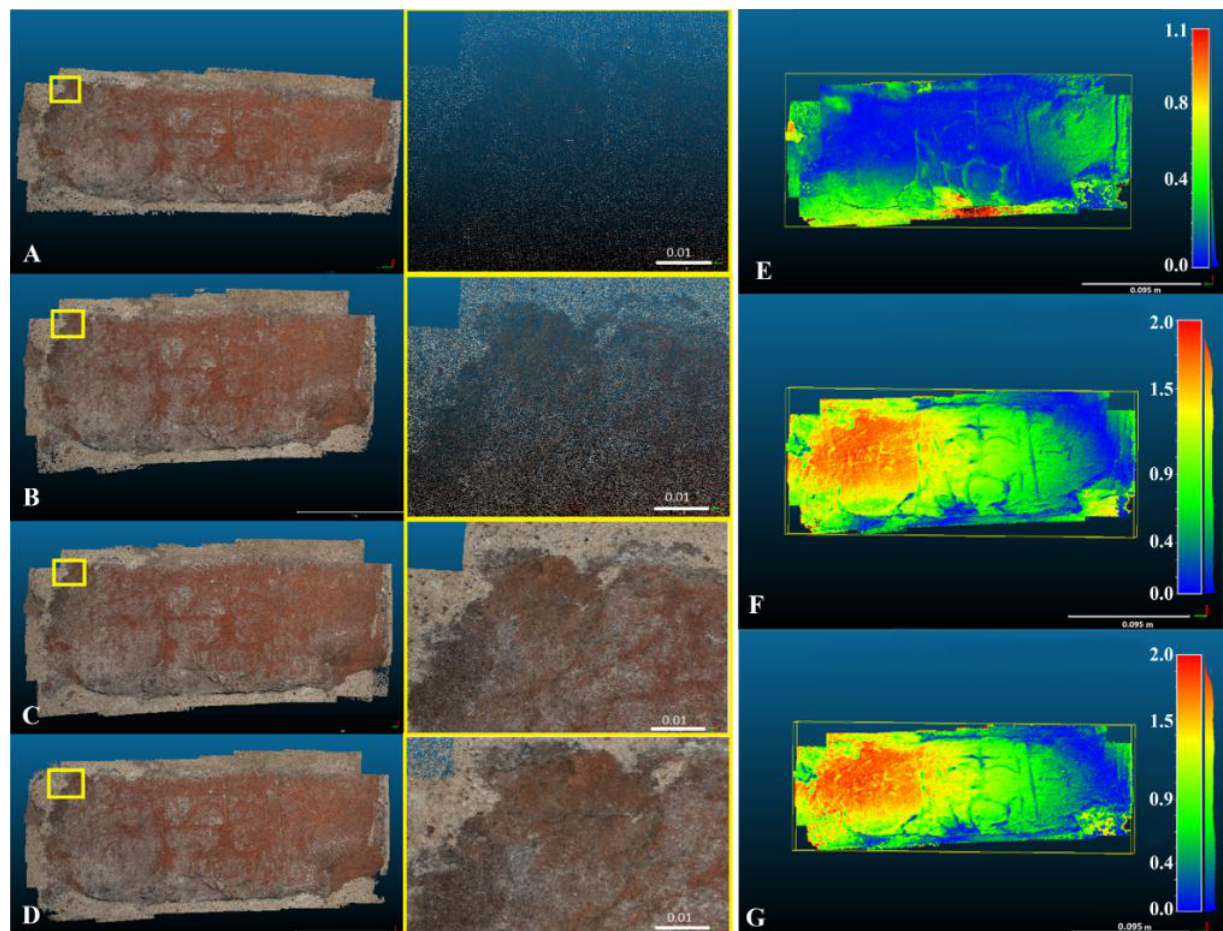
Figure 6. Generated point clouds at different levels of the image pyramid: A) Low (1/16 of the photograph resolution), B) Medium (1/4 of the photograph resolution), C) High (1/2 of the photograph resolution), D) Ultra high (the full resolution of the photograph). Comparison of distances between point clouds of different densities with the ultra-high cloud (in millimetres): E) High, F) Medium, G)